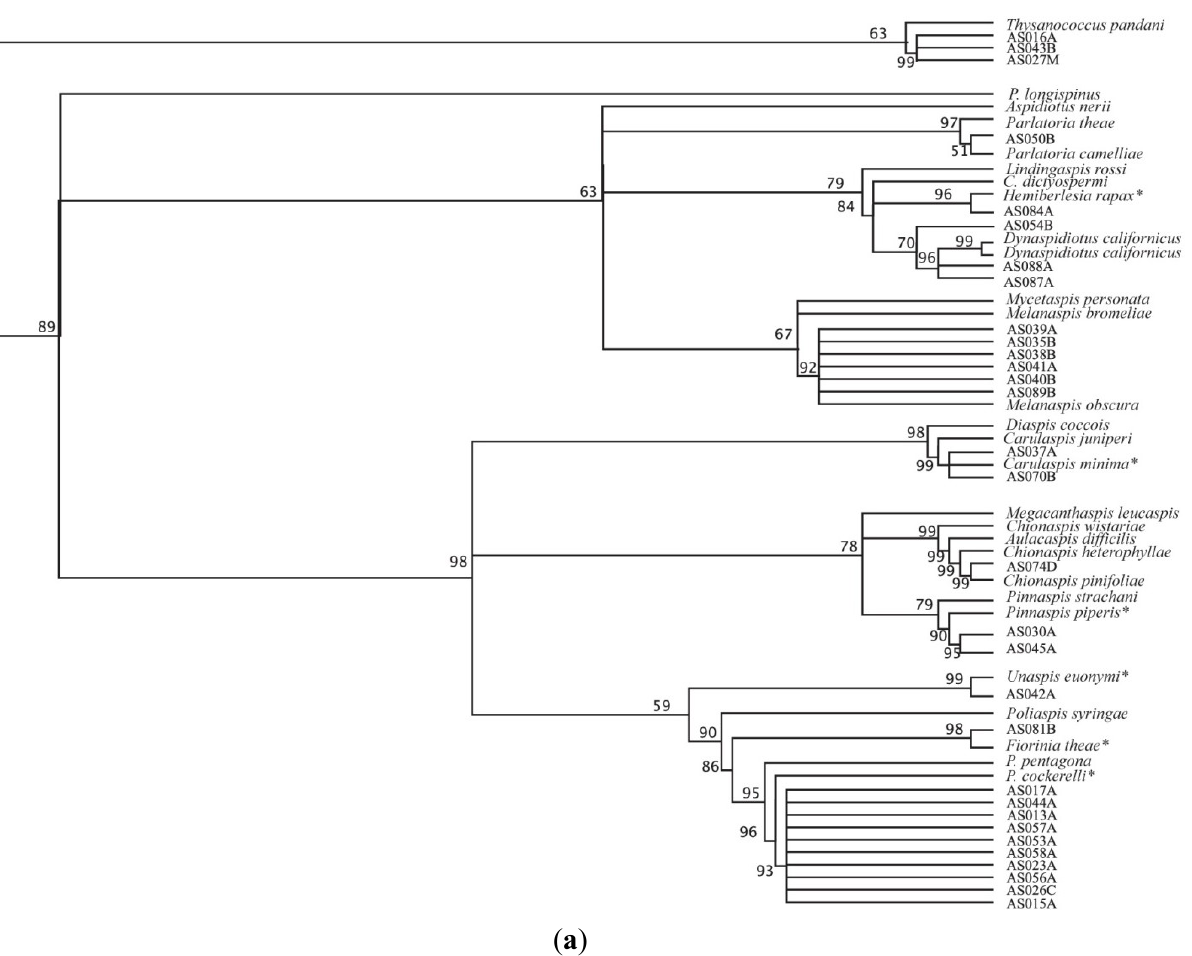
Figure 1. ( a ) Phylogeny of 28s utilizing Bayesian analysis. AS--- numbers indicate specimen sample numbers to correlate with collections at the Behrend Entomology Collection. Taxa provided with species names are from insects previously identified and sequenced and Genbank accession numbers are found in Table 2. An asterisk (*) indicates invasive status. Branch label indicates posterior probabilities. ( b ) Phylogeny of 16s utilizing Bayesian analysis. AS--- numbers indicate specimen sample numbers to correlate with collections at the Behrend Entomology Collection. Taxa provided with species names are from insects previously identified and sequenced and Genbank accession numbers are found in Table 2. An asterisk * indicates invasive status and a cross † indicates unknown invasive status. Branch label indicates posterior